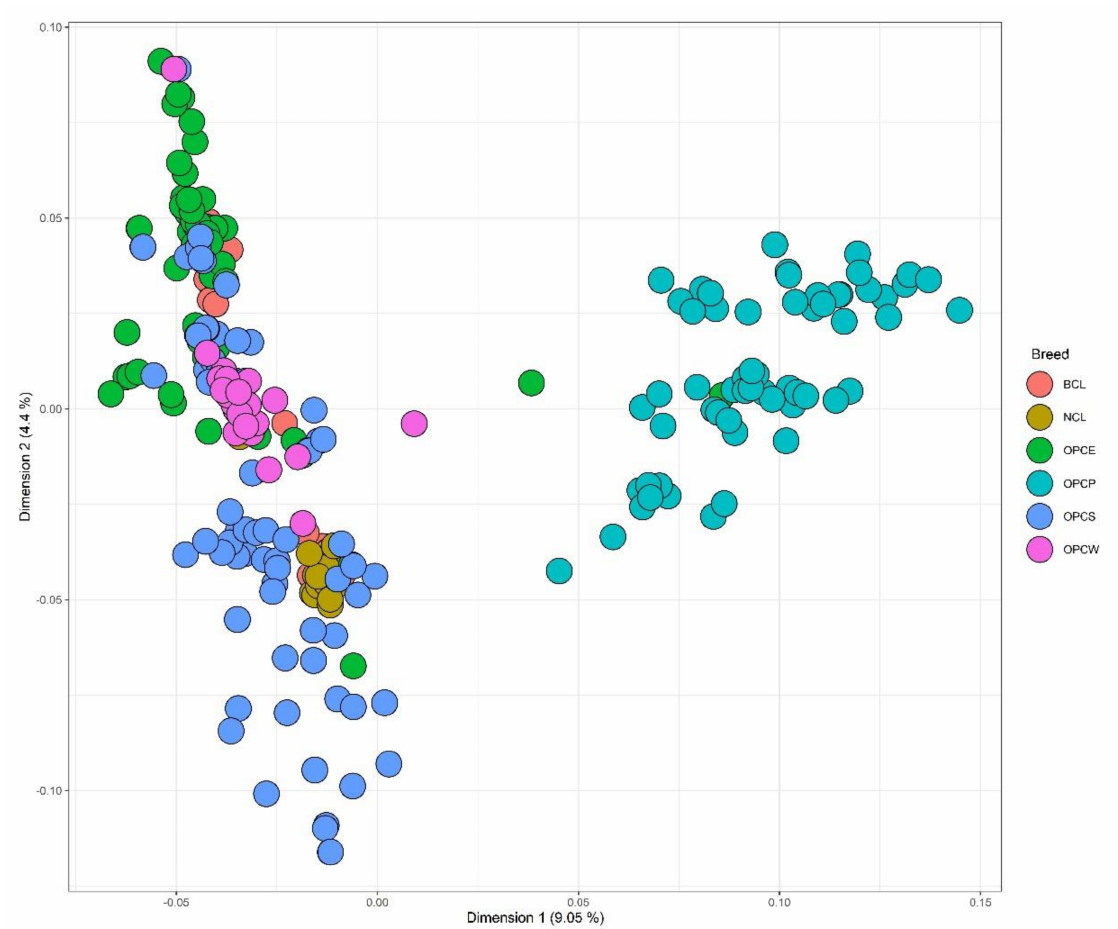
Figure 8. MDS plot constructed using the first two dimensions, showing the genetic relationships among the six Colombian populations (OPCP, OPCE, OPCS, OPCW, NCL,